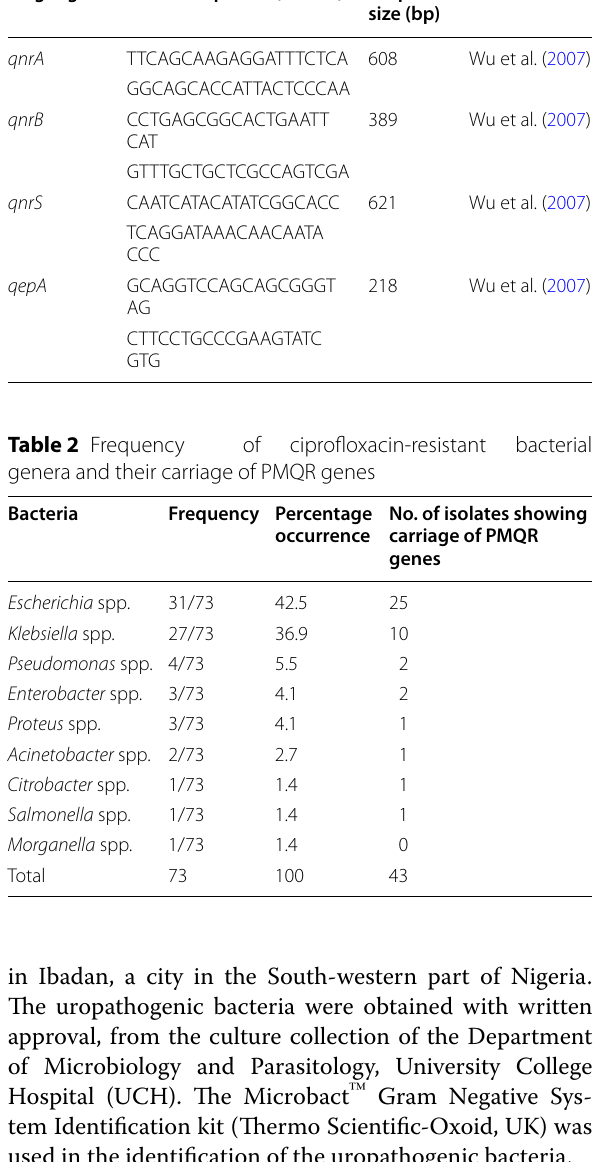
Table 1 Oligonucleotide primers and amplicon sizes of PMQR genes targeted in this study